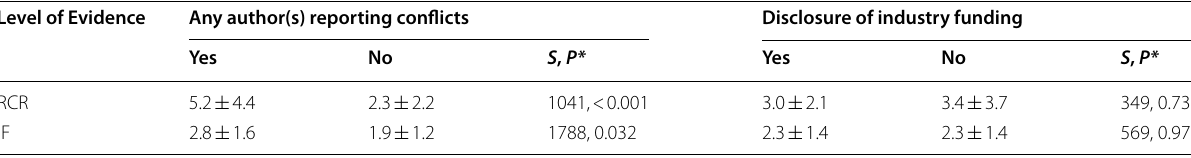
* Statistical results for Wilcoxon-Mann-Whitney tests